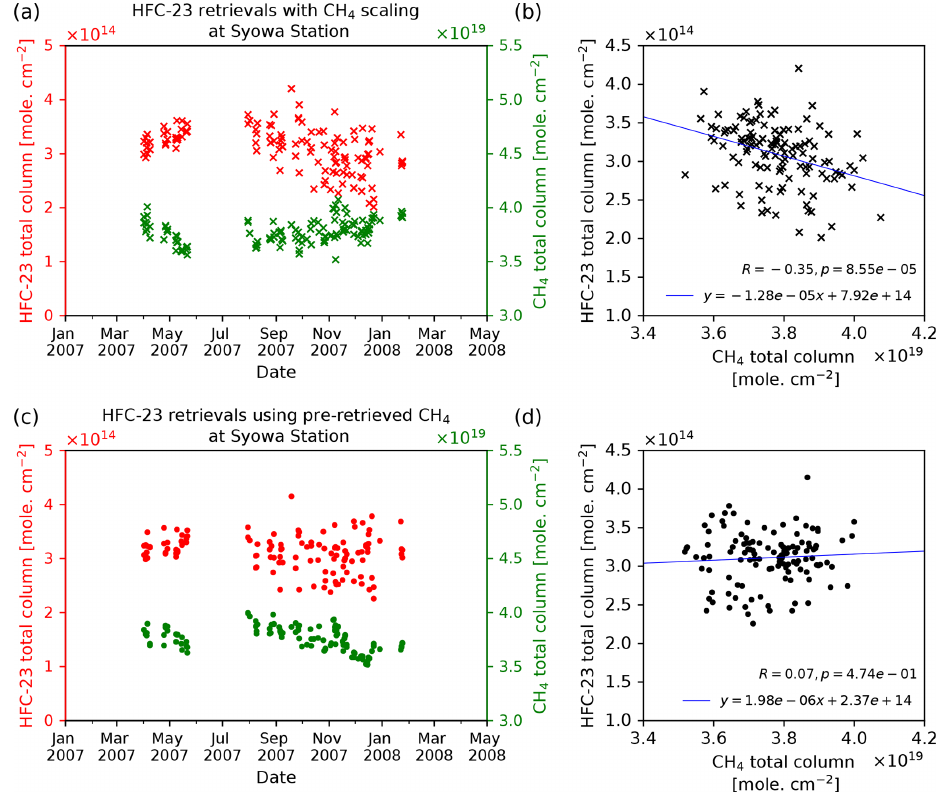
Figure 2. Time series of the total columns of HFC-23 and CH 4 retrieved from FTIR infrared spectra observed at Syowa Station in 2007 and January 2008. (a) HFC-23 total columns (red X plots) derived from HFC-23 retrievals accompanied by column retrieval (scaling) of the CH 4 profile and the scaled CH 4 total columns (green X plots). (b) The correlation between HFC-23 and CH 4 of (a) . (c) Independent retrieved CH 4 total columns using a spectral region from 1201.820 to 1202.605cm − 1 (green dots) and HFC-23 total columns from retrievals using the independent retrieved CH 4 profiles as fixed profiles (red dots). (d) The correlation between HFC-23 and CH 4 of (c) . Note that these retrieved HFC-23 columns were selected by the threshold of the fitted rms value depending on the value of the solar zenith angle (SZA): the thresholds of the fitted rms are < 0.5% for SZA < 85 ◦ and < 1.5% for SZA of 85 ◦ or